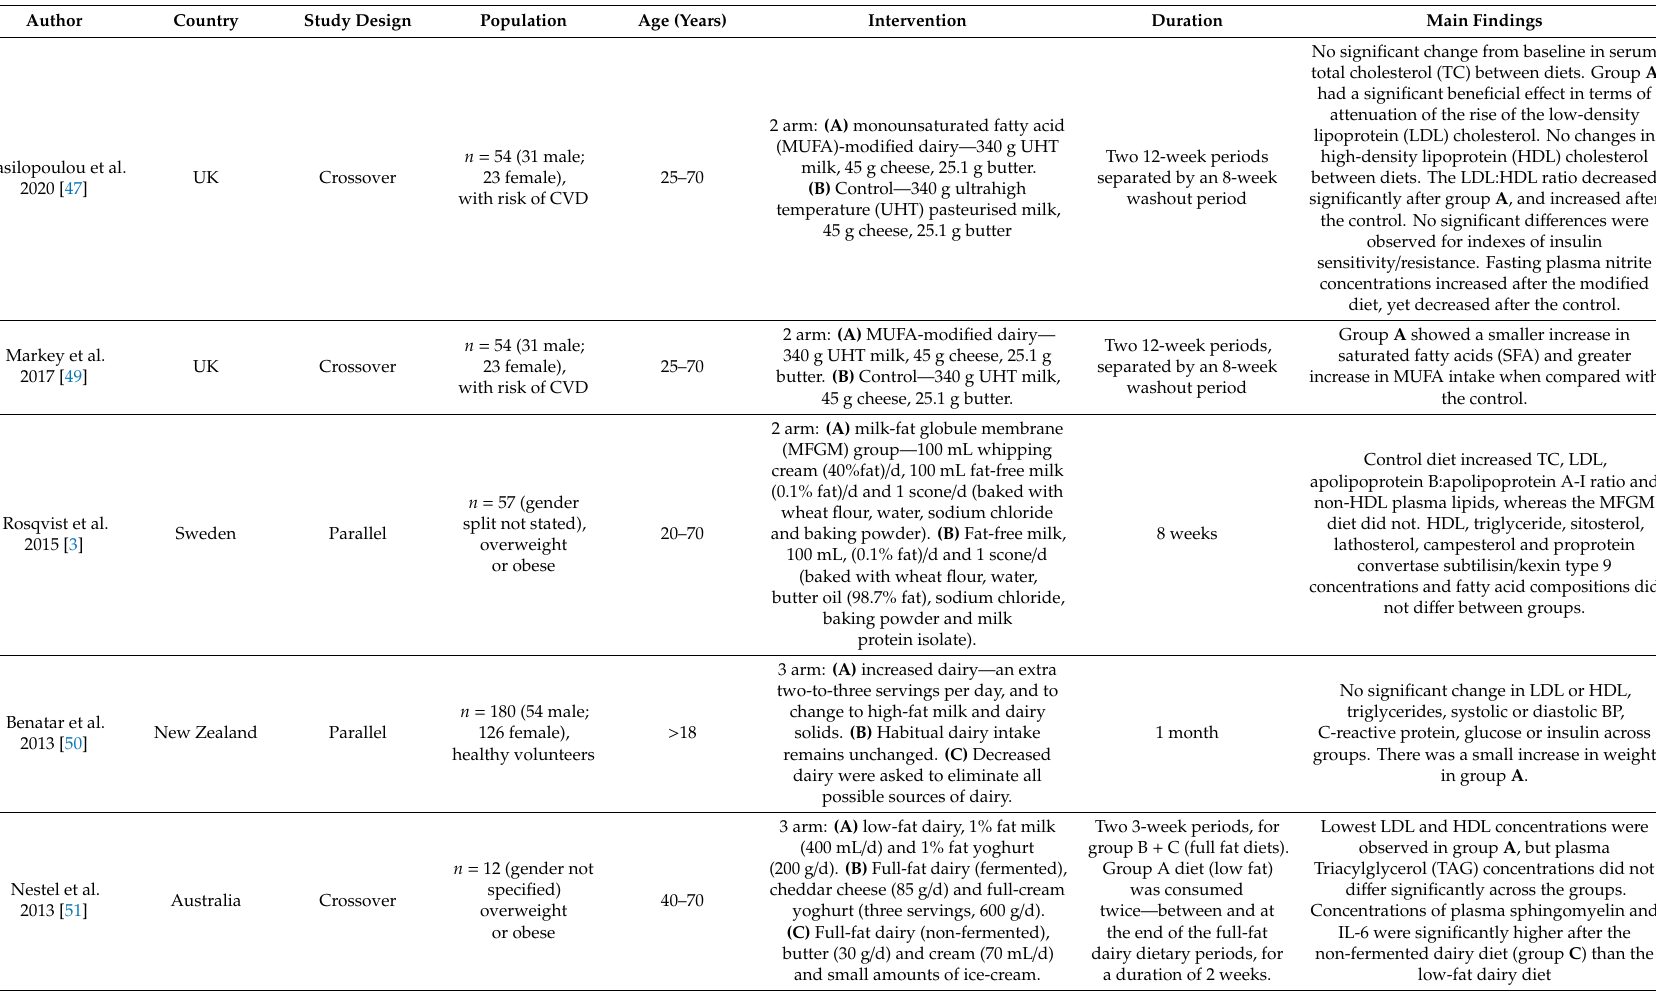
Table 1. Randomised controlled trials (RCT) demonstrating an e ff ect of overall dairy consumption on markers of metabolic health and cardiovascular disease (CVD)